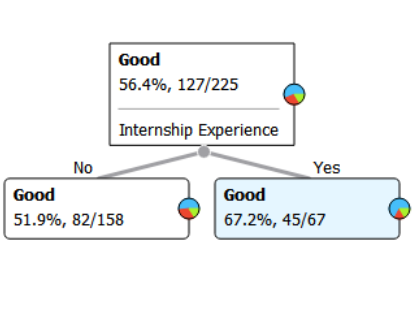
Fig. B2. Classification Tree with programming courses and